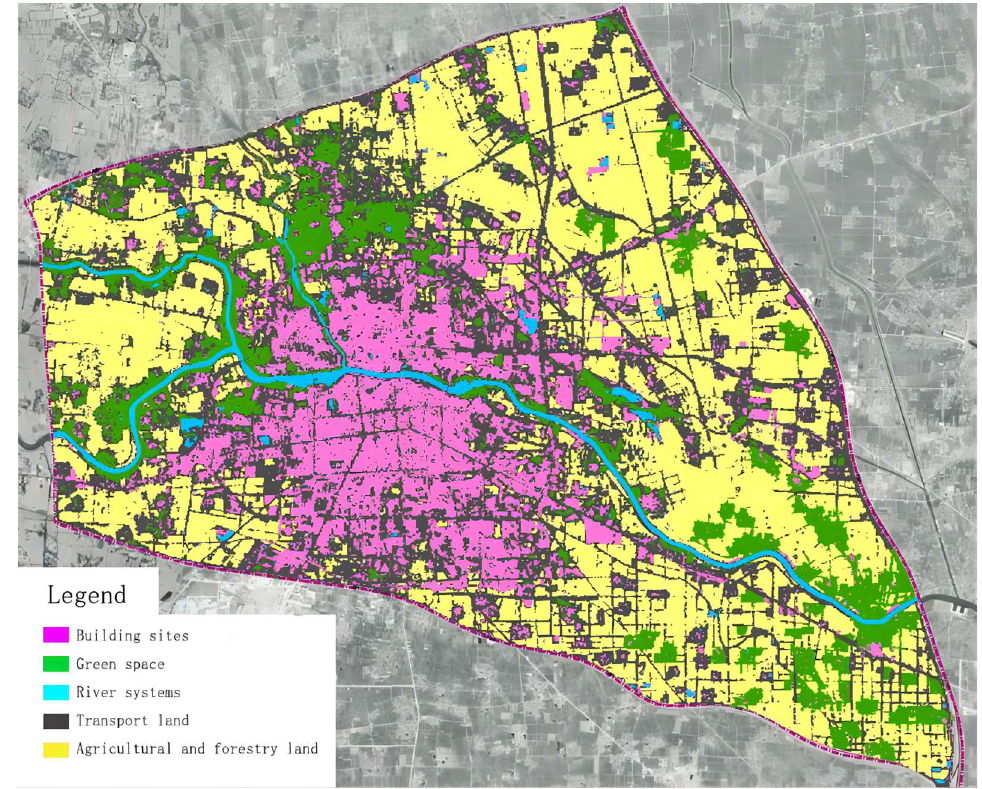
Figure 2. Zhoukou city center current sub-bedding surface map.